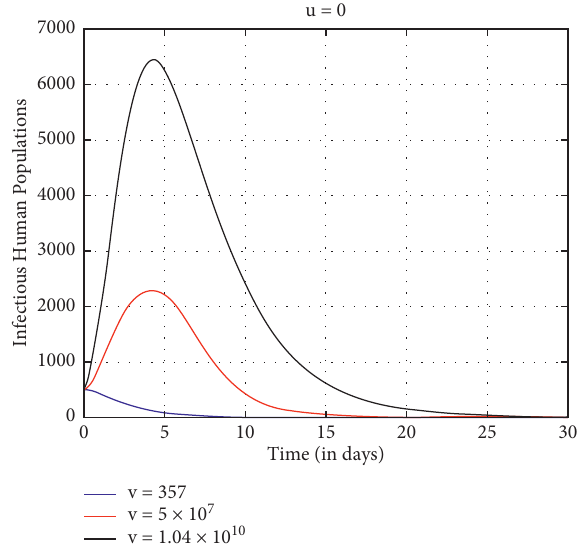
Figure 20: Infectious human population with different virus loads without fumigation.